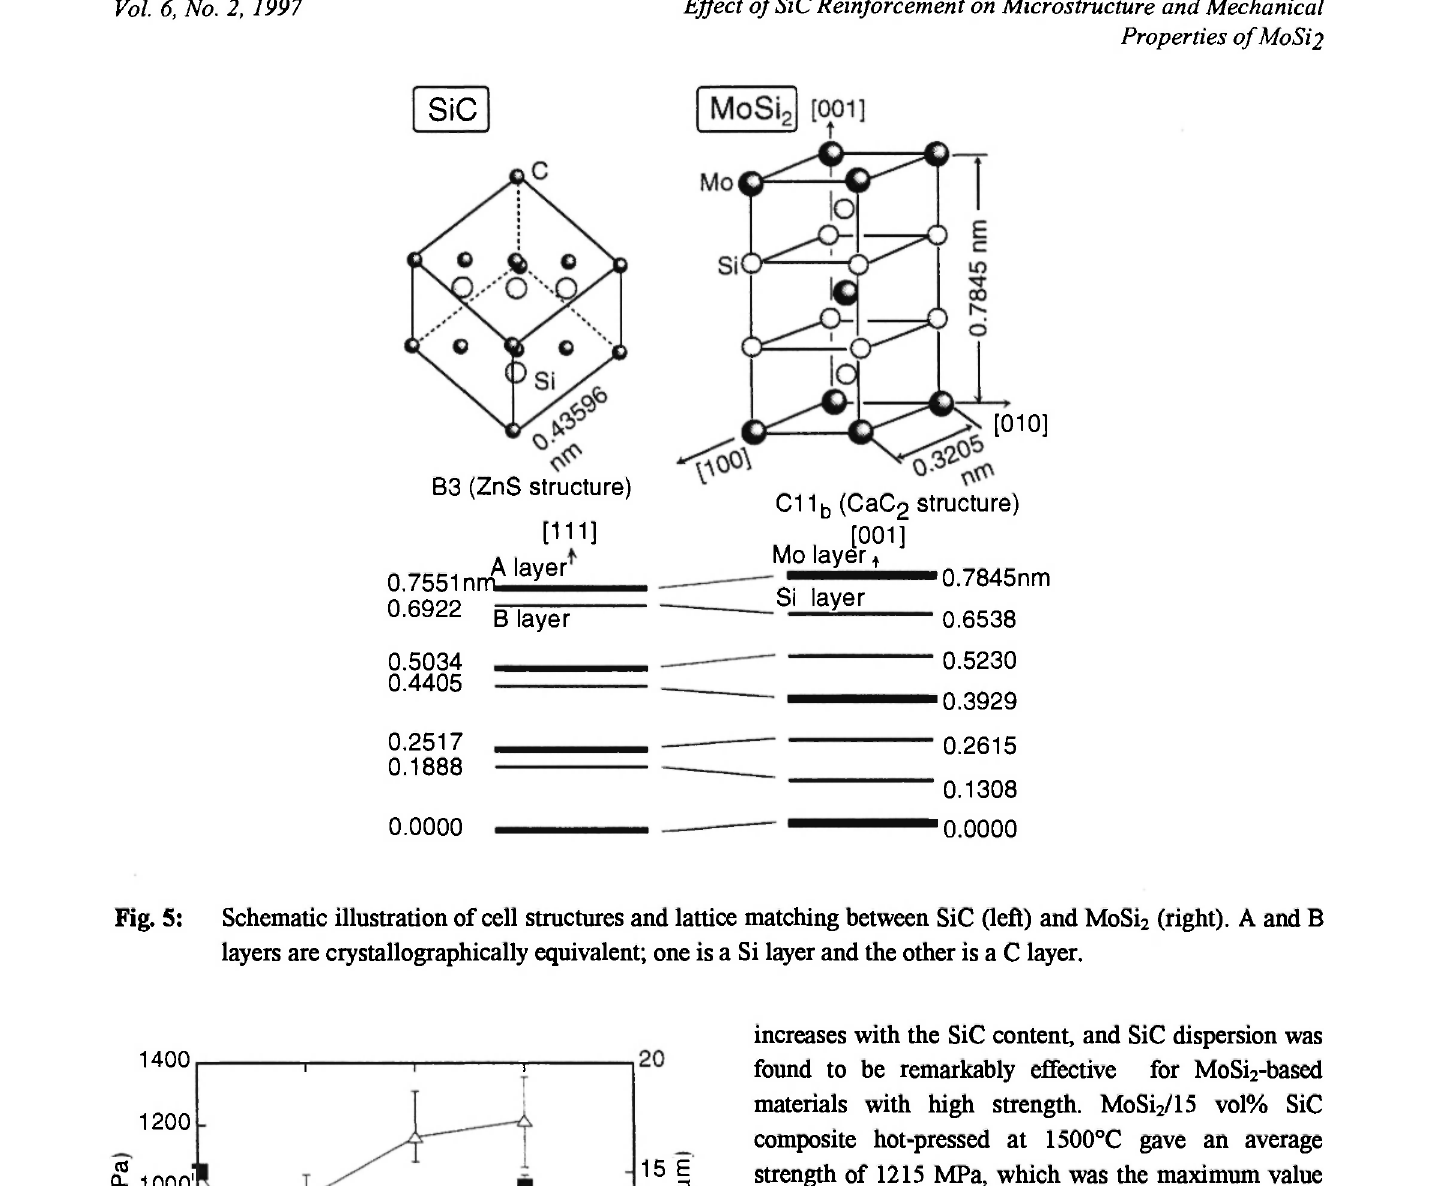
Fig. 5: Schematic illustration of cell structures and lattice matching between SiC (left) and MoSi layers are crystallographically equivalent; one is a Si layer and the other is a C layer.